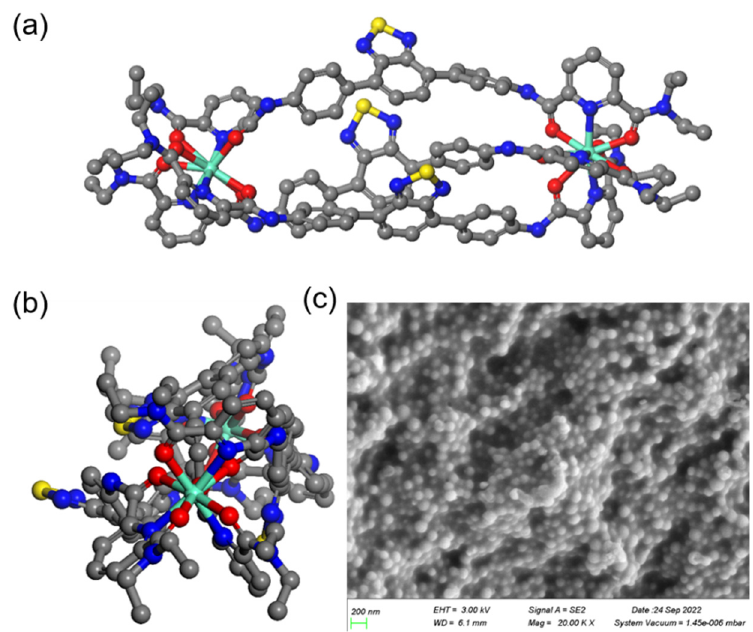
Figure 3. Energy-minimized molecular model of C A (Eu, green; N: blue; S, yellow; O, red; C, gray). Hydrogens, counteranions are omitted for clarity; ( a ) side view and ( b ) top view. ( c ) TEM images of C A .